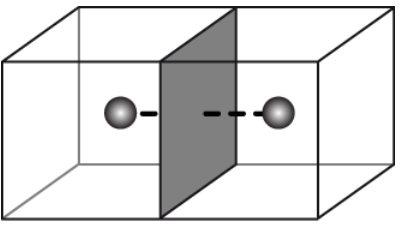
Figure 1. Two primal cells and their dual nodes linked by a dual edge (black dashed line).